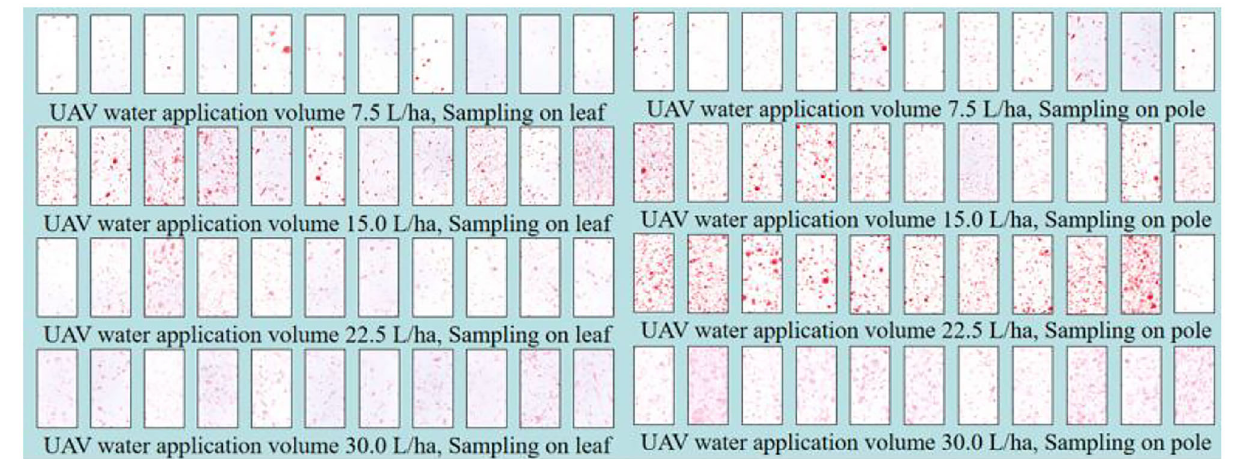
volume. The coefficients of determination of the droplet density and coverage were 0.89 and 0.92,